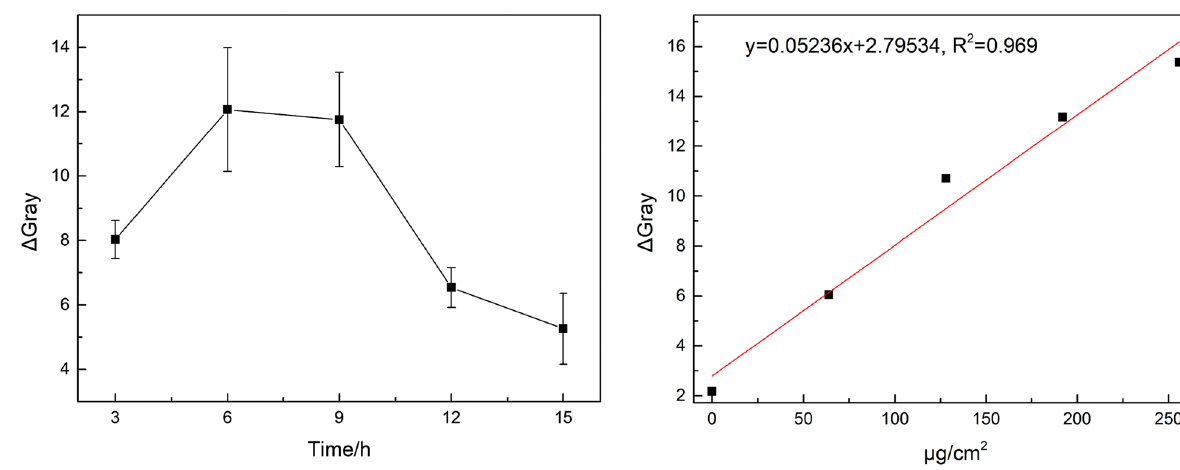
Figure 9: The standard curve line between adsorption and Δ Gray value of the NIM -